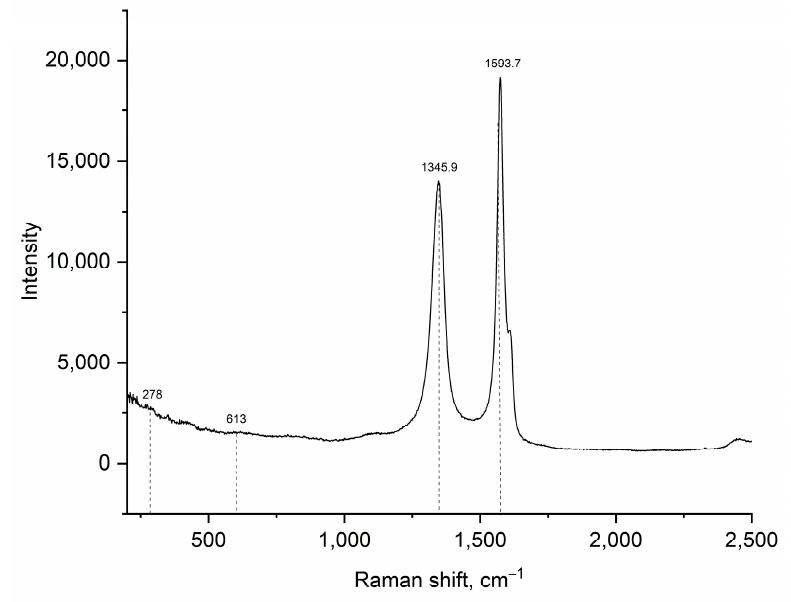
Figure 2. Raman spectra of CuFe 2 O 4 -70%/rGO/HNT.